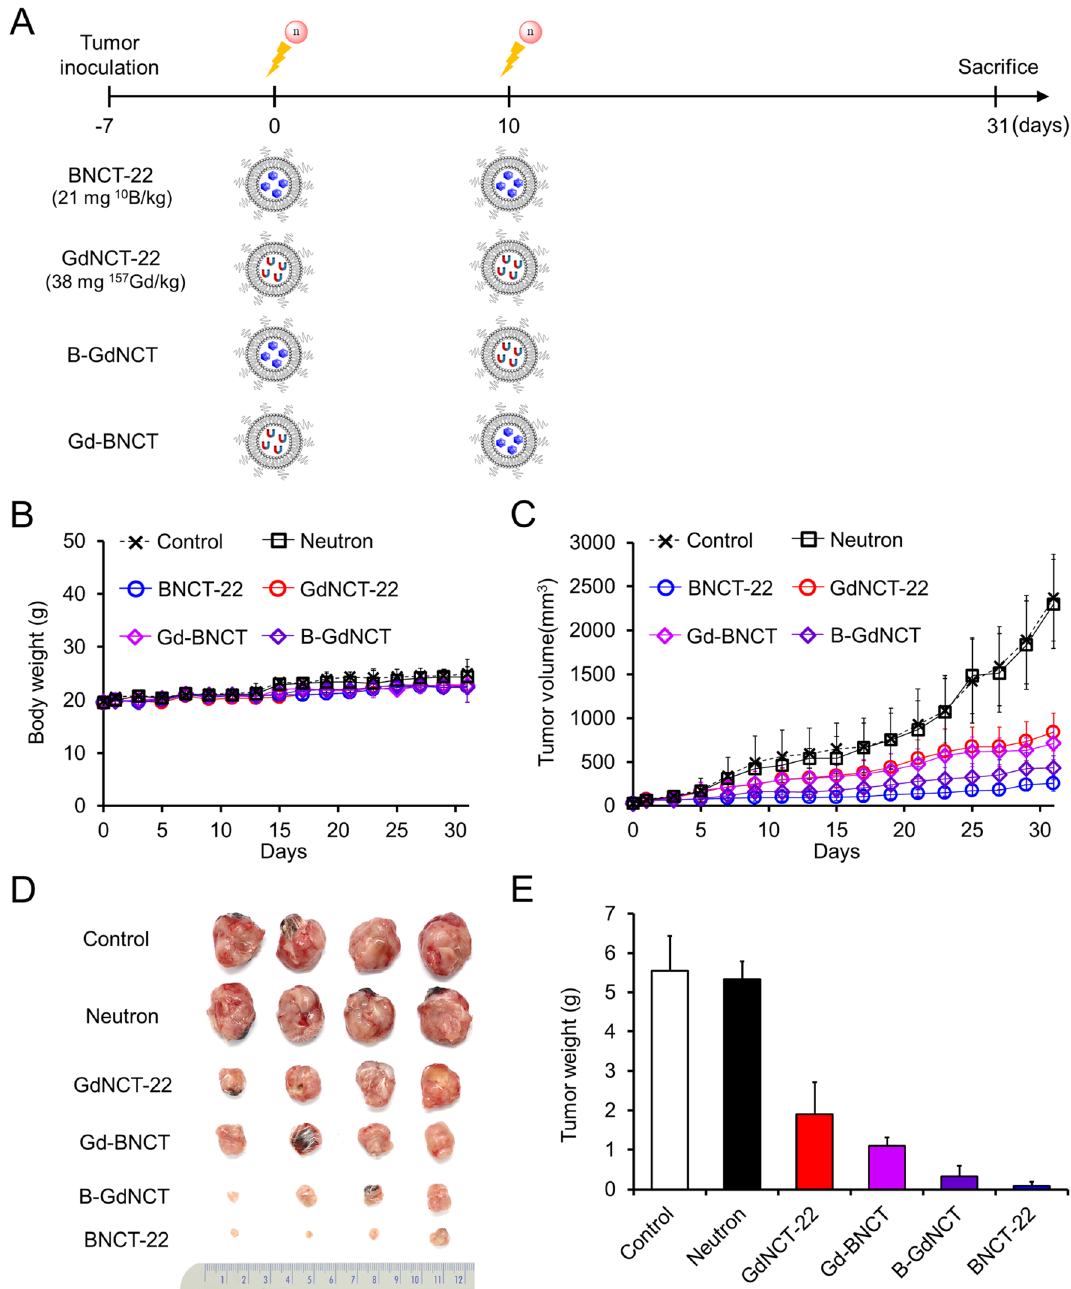
Figure 2. Results of single and combined BNCT and GdNCT using B-liposomes and Gd-liposomes in CT26 tumor-bearing mice (n = 4). ( A ) General experimental procedure for double injection and irradiation. ( B ) Body weights of each group after first neutron irradiation. ( C ) Tumor growth curves of each group after first neutron irradiation. ( D ) Photographs of tumors resected 31 days after the first neutron irradiation. ( E ) Average weights of tumors resected on day